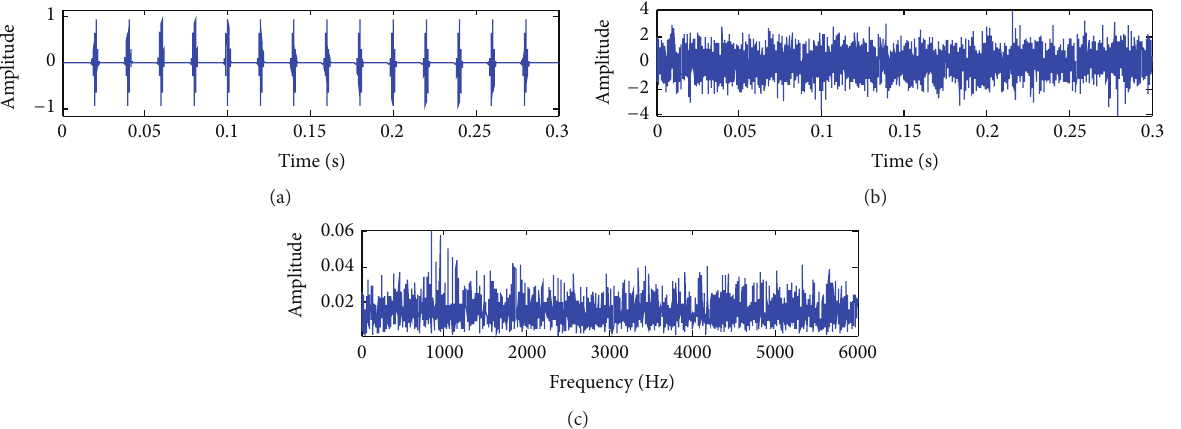
Figure 2: Simulated signal with single resonance frequency band: (a) time waveform for the pure signal; (b) time waveform for the mixed signal; (c) power spectrum for the mixed signal.